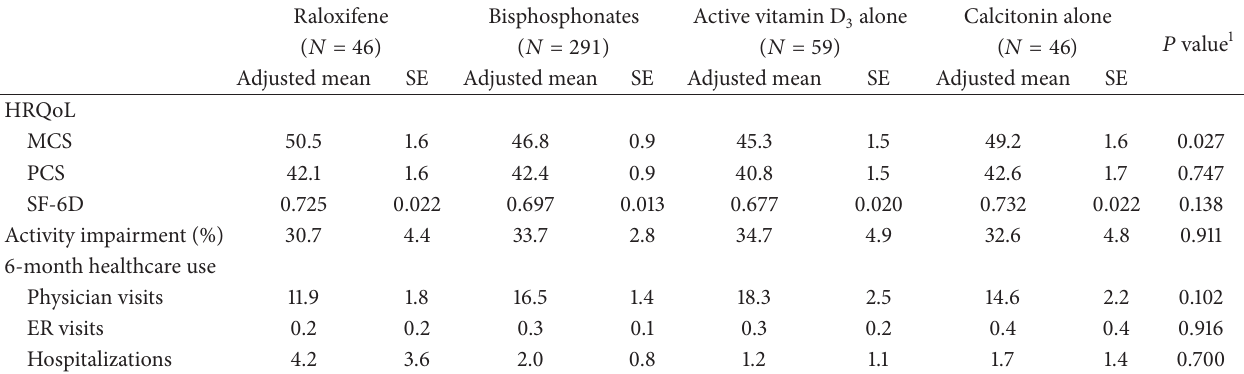
Table 5: Regression-adjusted mean outcomes according to type of osteoporosis treatment. Raloxifene Bisphosphonates Active vitamin D